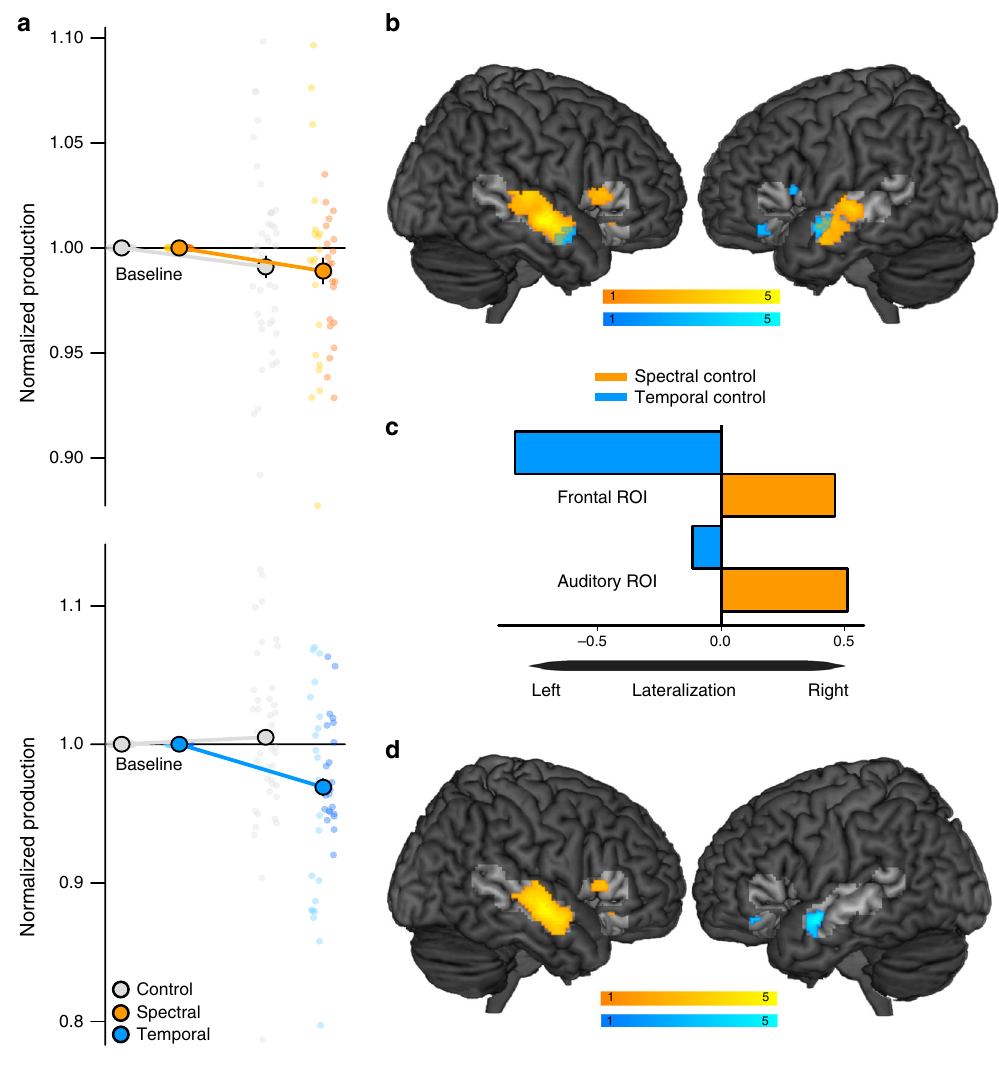
Fig. 3 Speech production with binaurally presented spectral and temporal feedback perturbations during fMRI. a Behavioral data. Produced speech feature relative to baseline during speaking with normal (gray) or spectrally (orange) or temporally (blue) altered auditory feedback. Smaller values indicate greater compensation. Data present estimated means ± model derived standard errors that account for between-subject variability ( n = 22 participants per group). Individual raw values for the control condition (grey) and following perturbations of the vowel (light colors n = 22 participants per group) or consonant (dark colors n = 22 participants per group) are plotted in the background. b Brain areas that activate during speaking with spectrally (orange) or temporally (blue) altered auditory feedback compared to normal speaking (perturbation vowel > no perturbation ∩ perturbation consonant > no perturbation), at p < 0.05 FWE, small volume cluster corrected for multiple comparisons with a cluster forming threshold of p < 0.001 (one-sided, paired t- test, n = 22 participants per group, color represents t -values, see color scales, search space is highlighted). Overlap in activity between spectral and temporal feedback control is shown in green. c Weighted lateralization indices in frontal and auditory ROIs during spectral (orange) and temporal (blue) feedback control. Negative values indicate left-lateralization, positive values right-lateralization. d Lateralized brain areas during speaking with spectrally (orange) or temporally (blue) altered auditory feedback compared to normal speaking (Lateralization pertvowel>noperturbation ∩ Lateralization pertfric>noperturbation ) at p < 0.05 FWE, small volume cluster corrected for multiple comparisons with a cluster forming threshold of p < 0.001 (one-sided, paired t- test, n = 22 participants per group, color represents t -values, see color scales, search space is highlighted). P -values for panels b and d are provided in Tables 1 and 2. Source data of panel a and c are provided as a Source Data fi